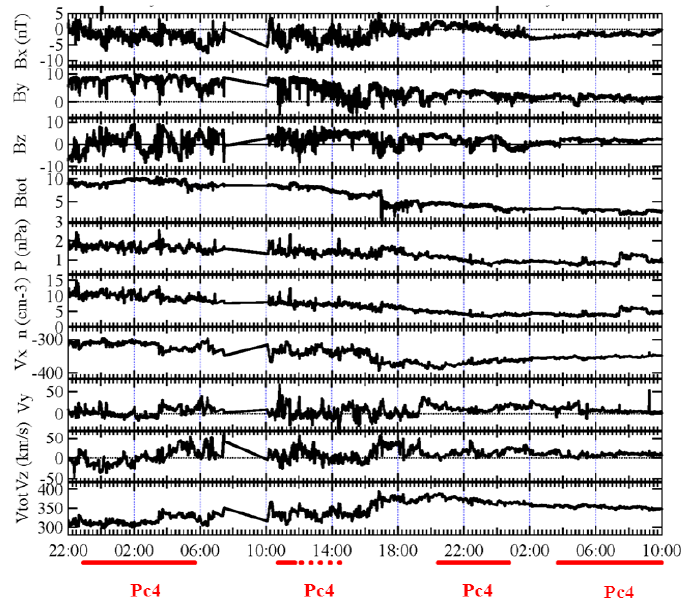
Figure 2. Wind plasma and magnetic field observations in GSM coordinates from 22:00:00UT on 30 April 2014 to 10:00UT on 2 May 2014. Solid red bars show time-shifted intervals when Pc4 magnetic field pulsations were observed by multiple spacecraft. Dashed red bars indicate times when the Pc4 pulsations were observed in the electric field, not in the magnetic field. (See text in Sect.